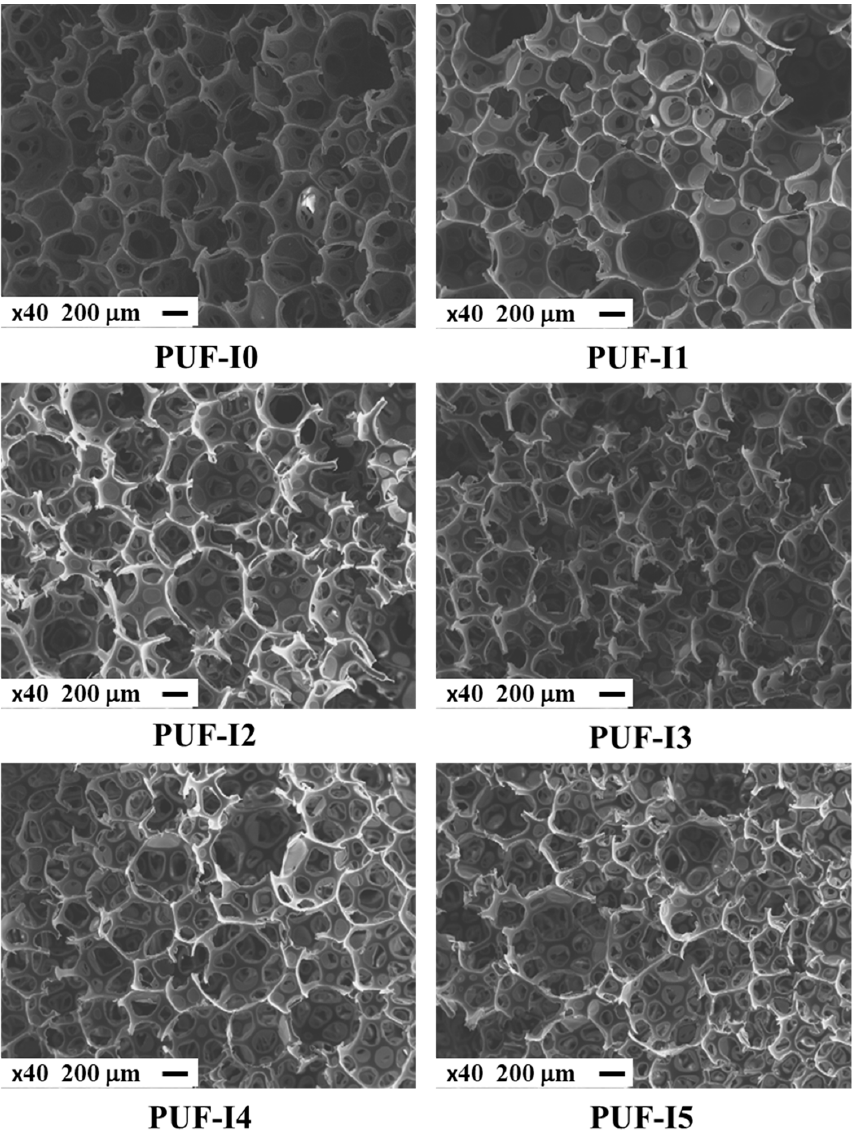
Figure 8. SEM images of the FPUFs after thermal treatment at 160 °C.